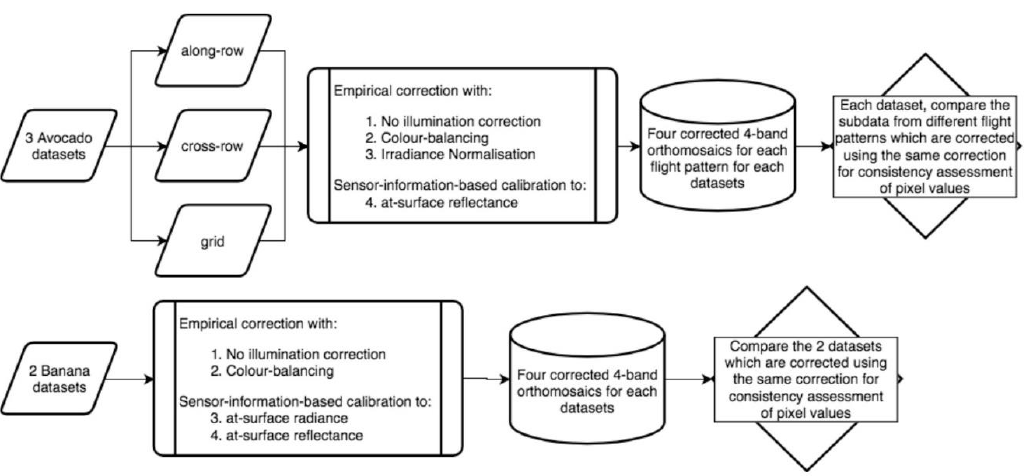
Figure 4. Conceptual workflow of the radiometric correction